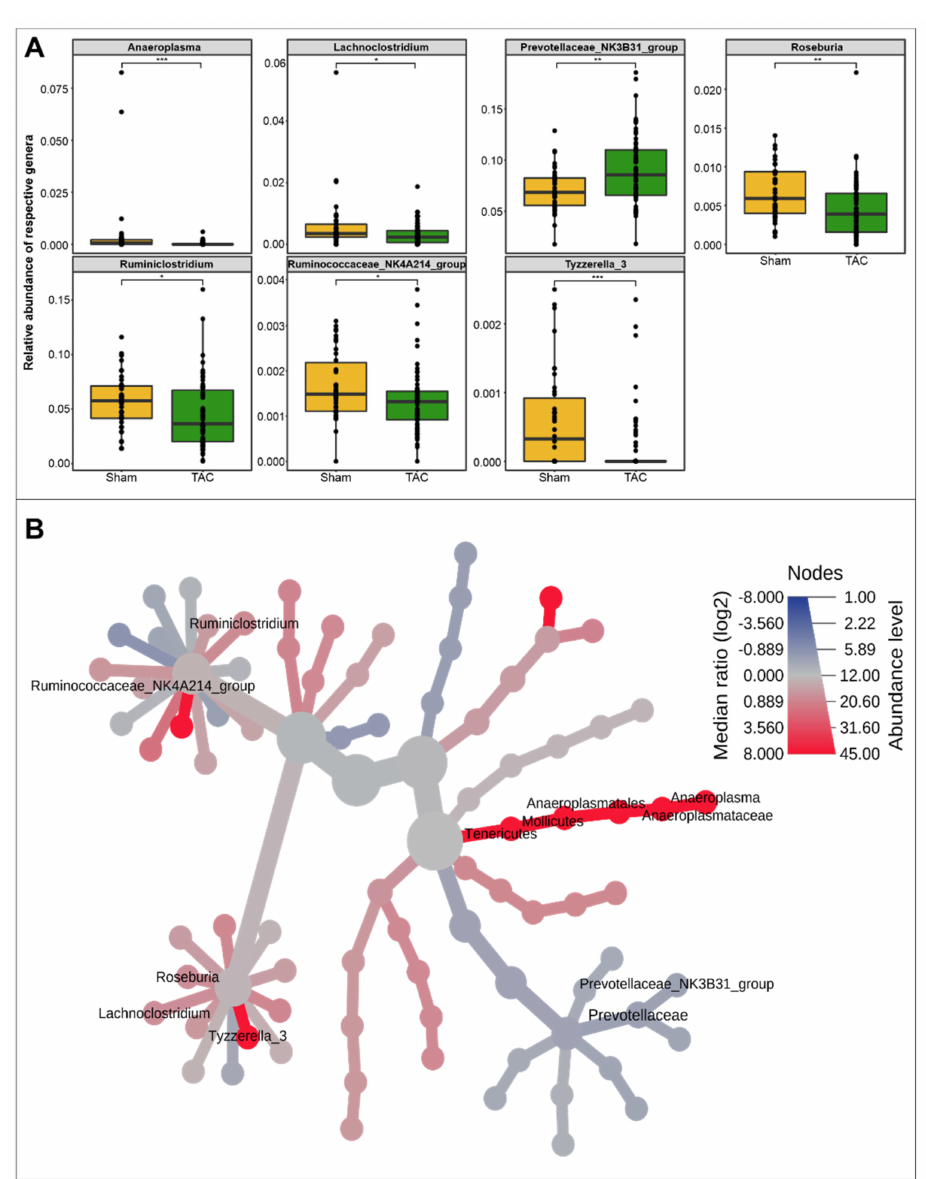
Figure 2. Comparative analysis of gut microbial content in Sham Vs. TAC mice. ( A ) Box plot showing relative abundances of the total of 7 genera that were found to be differentially abundant using Wilcoxon’s test in the Sham and TAC comparison, indicating that most of the genera were found to be more abundant in Sham samples as compared to TAC samples (*, **, and *** correspond to p ≤ 0.05, p ≤ 0.01, and p ≤ 0.001, respectively). ( n values are as follows: Sham = 38, TAC = 63). ( B ) Heat-tree showing significantly different genera in the Sham and TAC comparison using Wilcoxon’s test ( p -value ≤ 0.05). ( n values are as follows: Sham = 38, TAC =